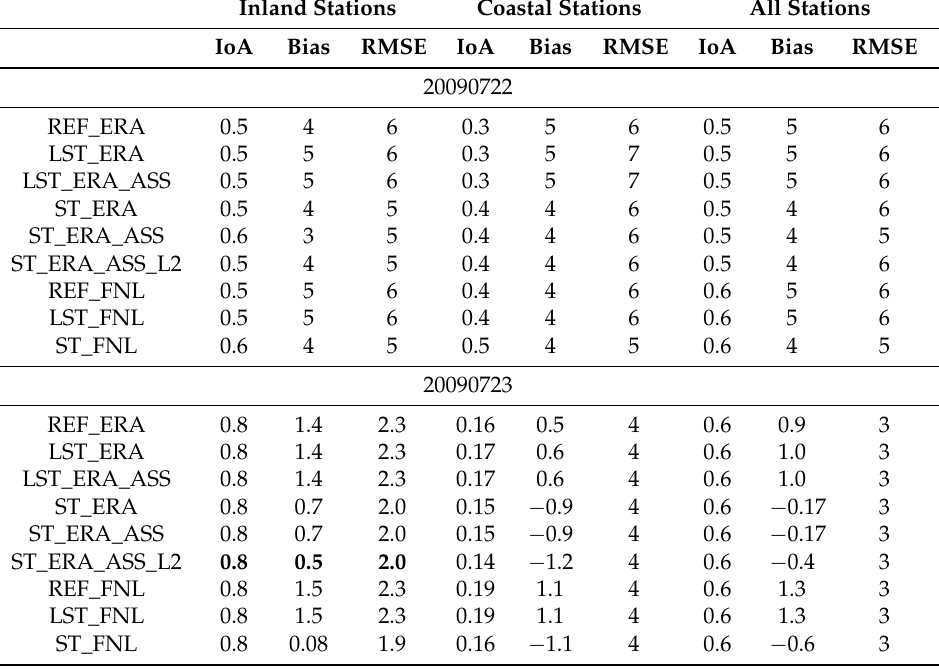
Table 4. Statistical scores for the maximum temperatures considering the different sensitivity tests performed using the RAMS diagnostic environment, taking into account each day of simulation